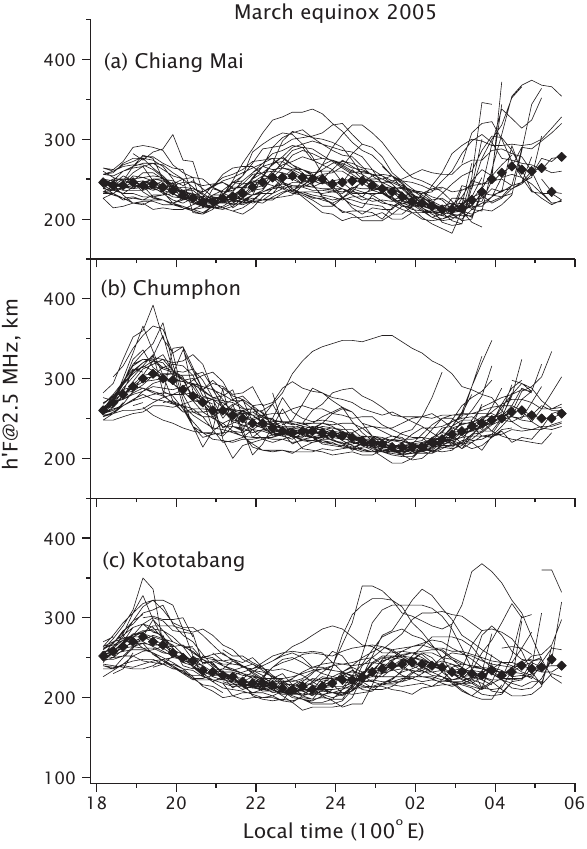
Fig. 8. The same as Fig. 5 but for the period from 5 June to 7 July 2005 (June